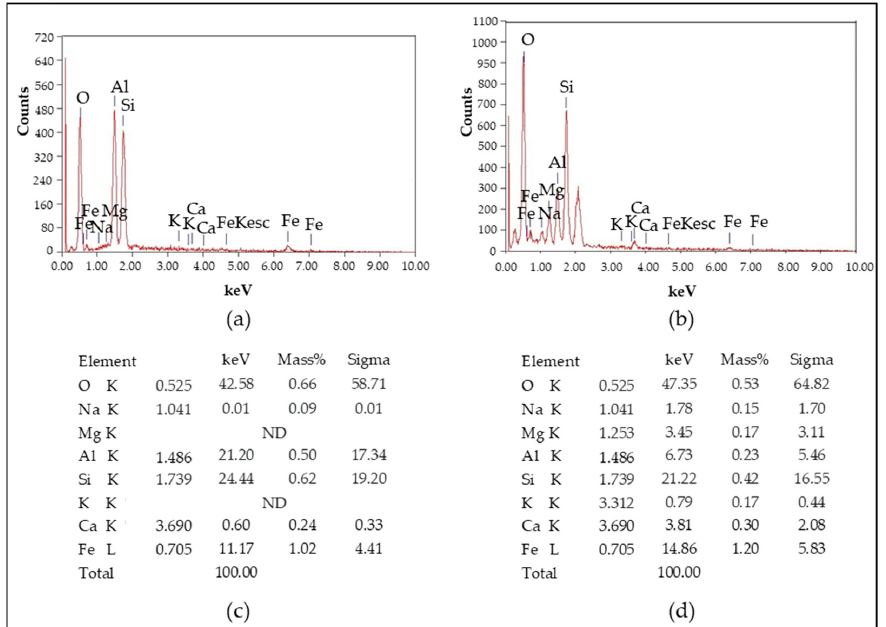
Figure 3. EDX analysis of raw materials: ( a ) spectra of LLRC; ( b ) spectra of LSBC; ( c ) Elemental Composition of LLRC; ( d ) Elemental Composition of LSBC.